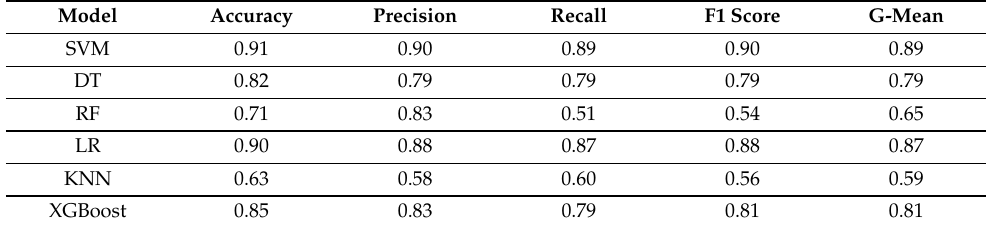
Table 14. The results using the hashing features.